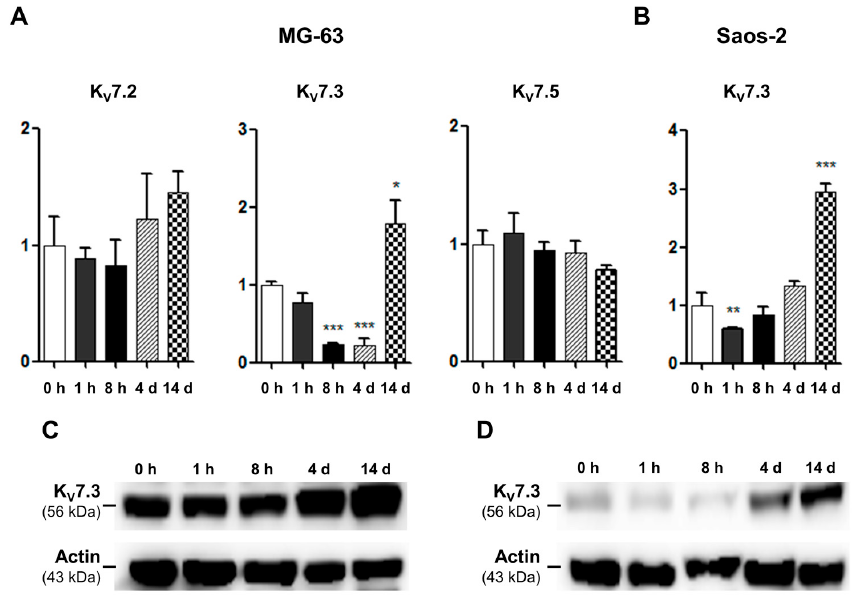
Figure 3. Changes in K V 7 channel expression during osteoblastic differentiation. The relative expression levels of K V 7.2, K V 7.3, and K V 7.5 during osteoblast differentiation were analyzed by qRT-PCR. ( A ) In MG-63 cells, mRNA expressions of K V 7.2 and K V 7.5 were not significantly changed ( n = 3). However, K V 7.3 transcripts decreased for 4 days after osteoblast induction, whereas, at day 14, the K V 7.3 mRNA level was considerably increased ( n = 4); ( B ) In Saos-2 cells, mRNA expression of K V 7.3 was reduced 1 h after osteoblast induction, but was significantly augmented at day 14 ( n = 4); ( C , D ) The expression of K V 7.3 proteins was increased at day 4 of osteoblast induction ( n = 3). Data are presented as mean ± SEM. * p < 0.05; ** p < 0.01; and *** p < 0.005. d: day.